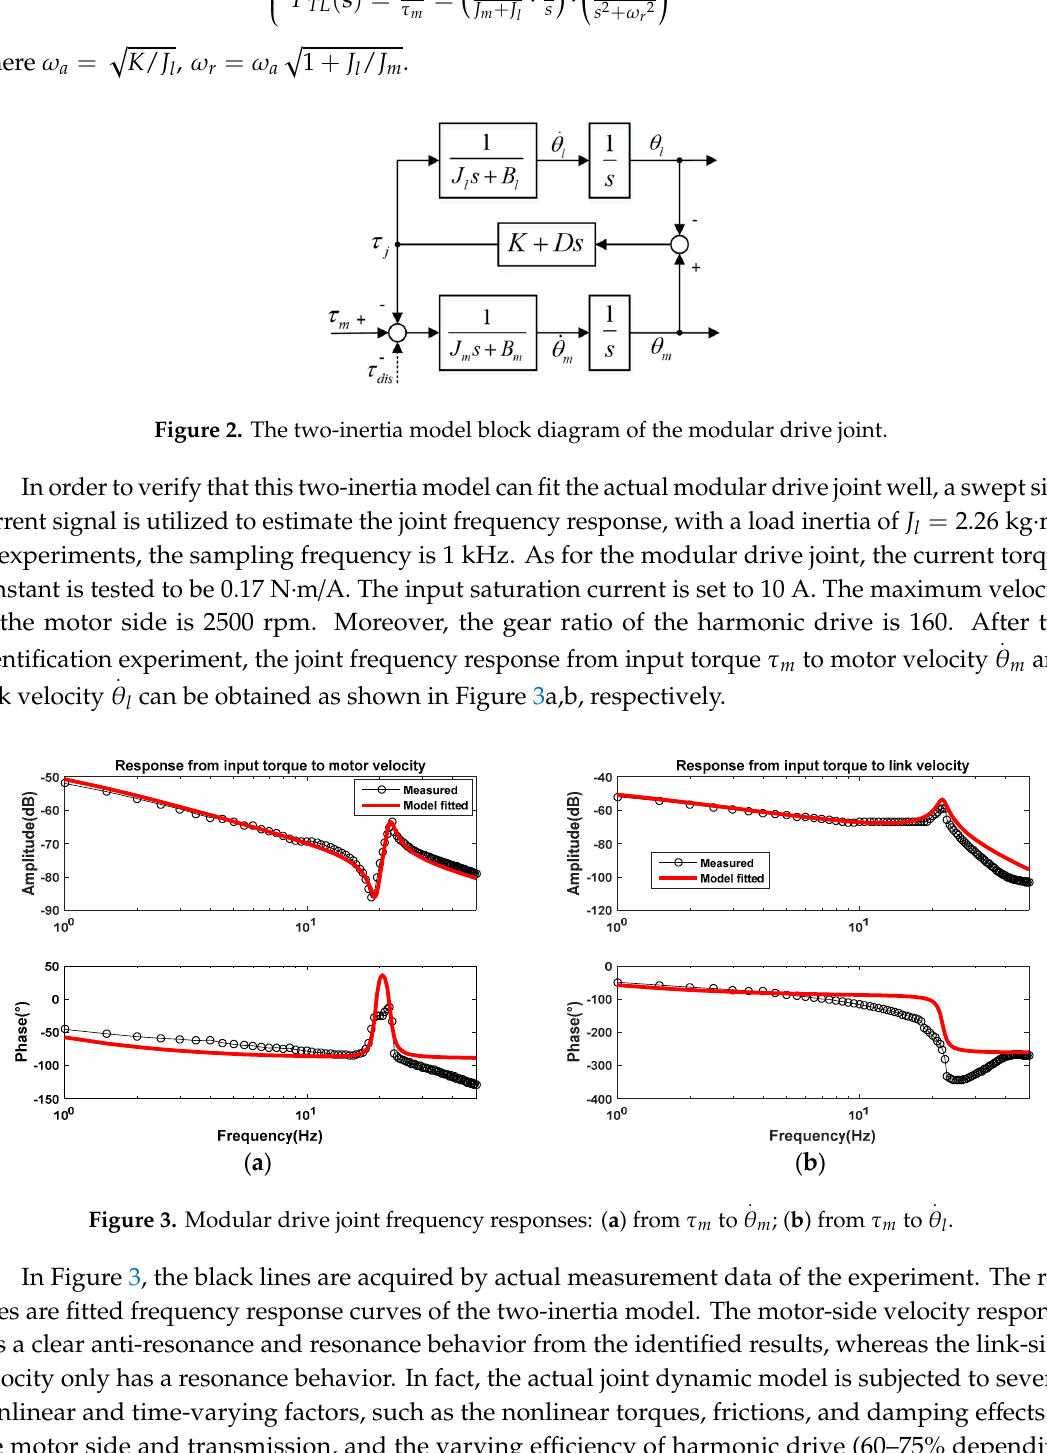
θ  ; ( b ) from θ  . τ to τ to m l m m